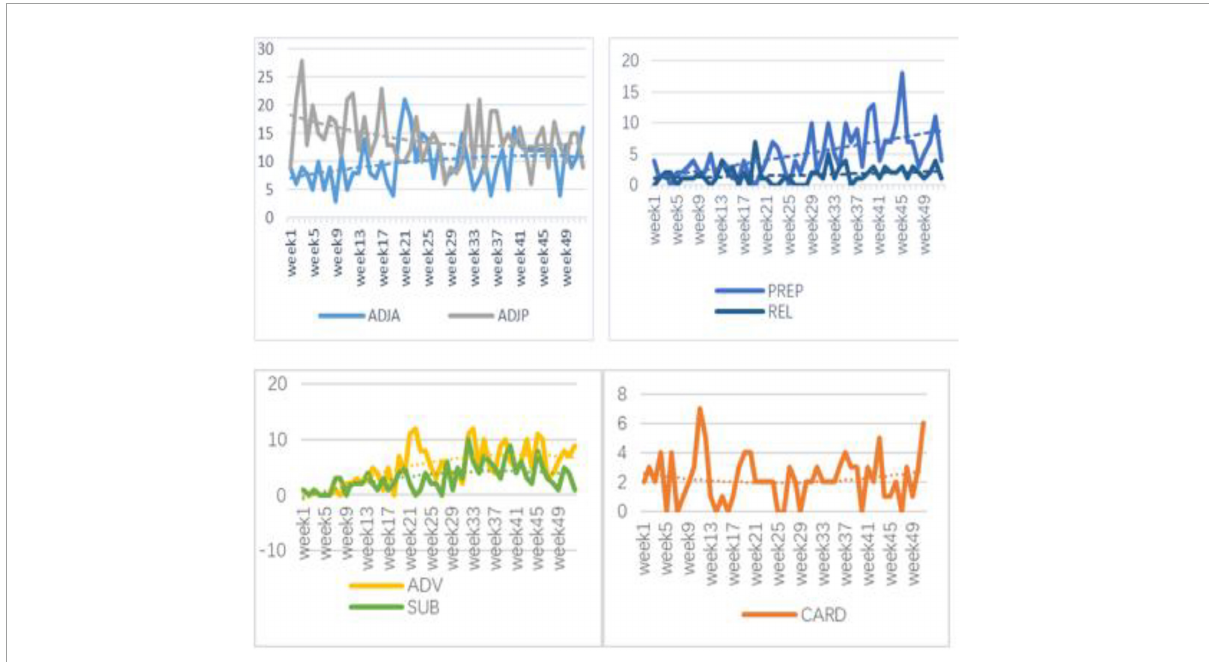
FIGURE3 The development of seven fine-grained measures over time.